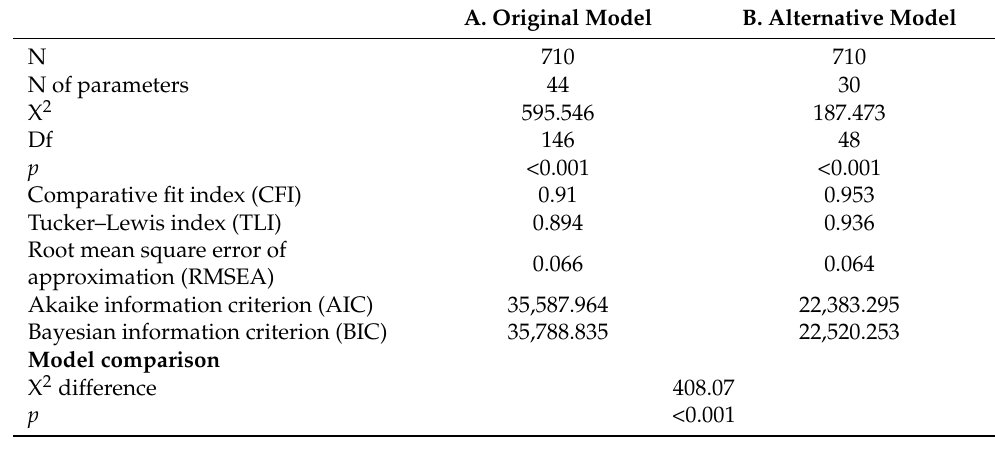
Table 1. Goodness of fit of the original and alternative model.